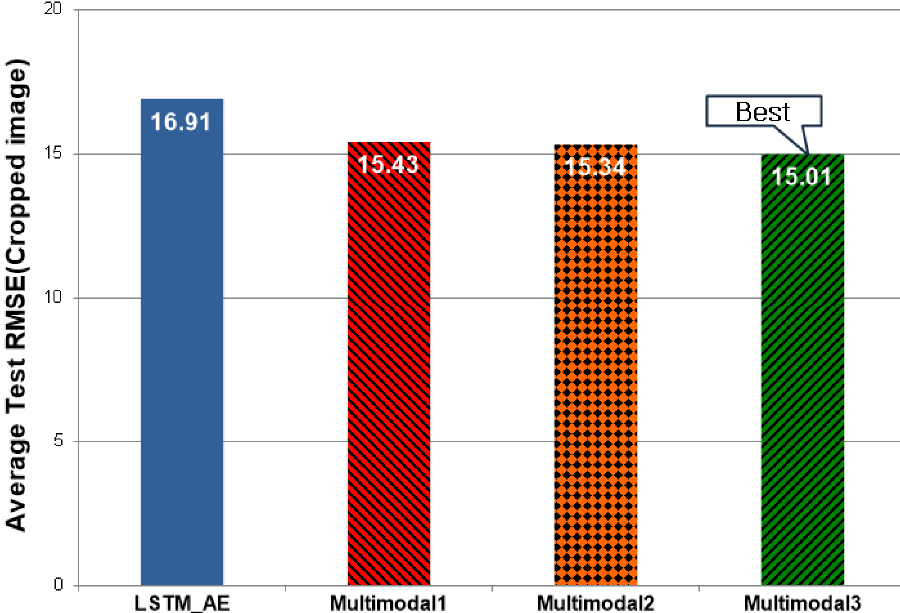
Figure 12. Average Test RMSE for each model using the cropped image.